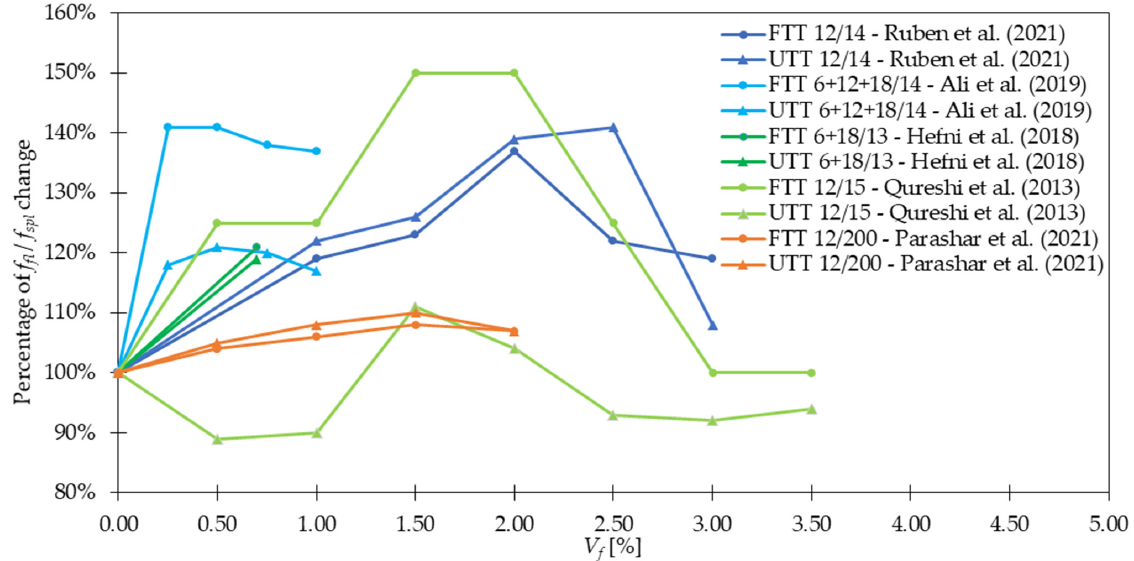
Figure 15. Change of f fl / f spl in relation to V f for different fiber geometry l f /d f [21,36,49]. 4.4. Post-Cracking Behavior, Ductility, and Toughness When studying the post-cracking behavior of concrete, it is important to analyze the fracture energy ( G f ), which is the energy required to break the sample, and fracture tough- ness ( K IC ) which is defined as the ability of the specimen to resist brittle failure or crack extension [22]. In the work [22], fracture energy increased by 40, 46, and 64% for samples with 0.50, 0.75, and 1.00% of GF, respectively when compared with PC. Additionally, the fracture toughness was around 1.37 and 1.75 times higher for GFRC with 0.50 and 1.00% of GF, respectively than that for PC. Findings that GF have a remarkably positive impact on concrete ductility were also recognized in the work of Morteza, et al. [32]. From the toughness indices calculation according to ASTM C1018 [90], it was concluded that with the increase in fiber content, the indices I 5 , I 10 , and I 20 also rose (Figure 16). Moreover, for higher GF dosages the differences between individual indices were greater. Additionally,